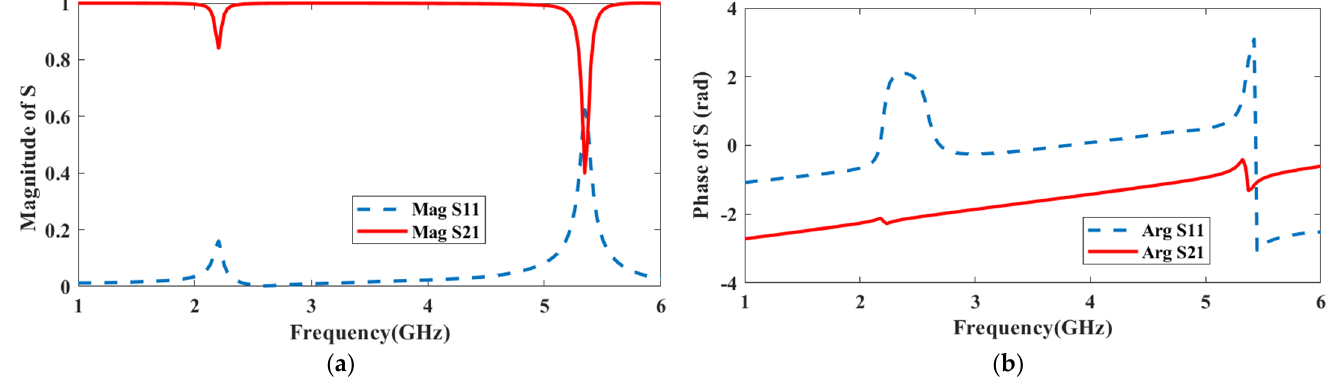
Figure 4. S 11 and S 21 ( a ) magnitude and ( b ) phase plots of the CDNG structure .